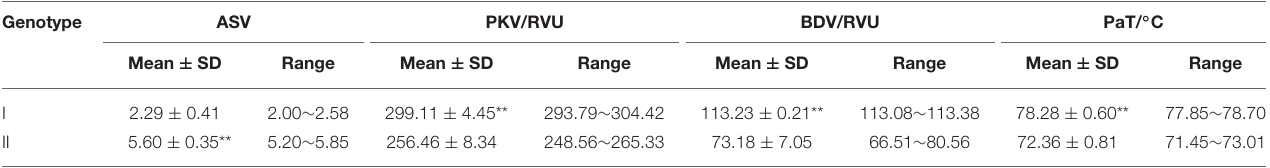
TABLE 1 | Comparison of effects of different SSIII-2 alleles under background of Wx b .